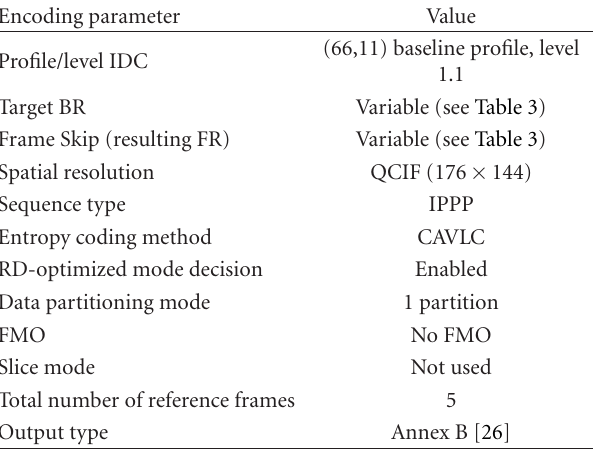
Table 2: Encoding parameter